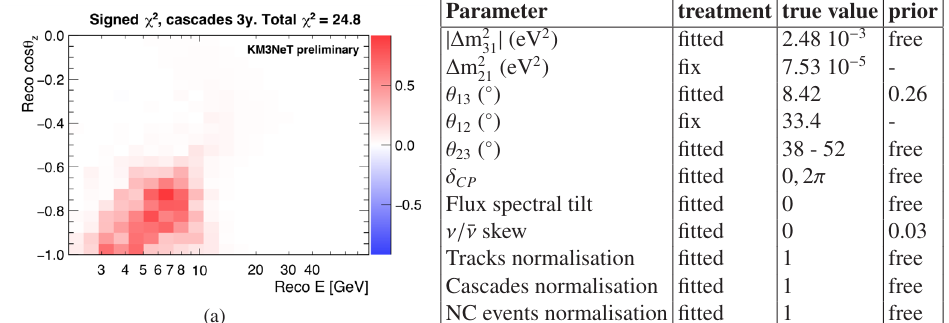
Table 1 . Oscillation and nuisance parameters, and systematic uncertainties used for the NMO